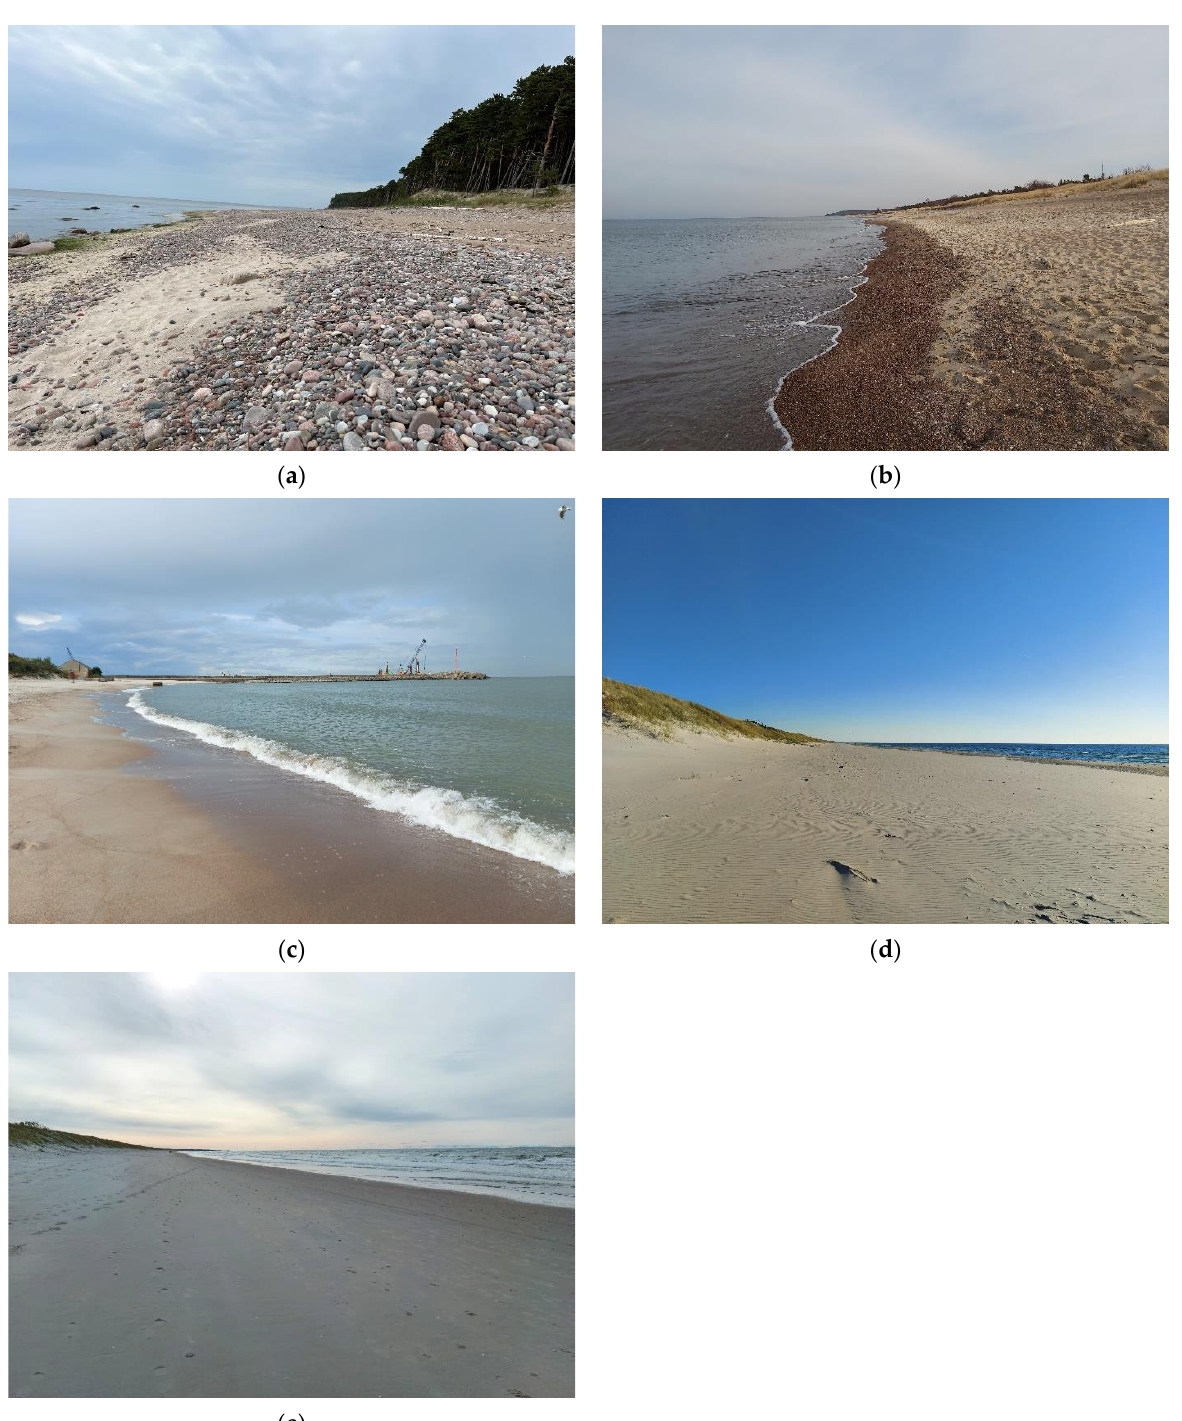
Figure 3 . Klaip ėda district municipality ’ s coast ( a ) Karklė; Klaipėda city municipality’ s official Figure 3. Klaip˙eda district municipality’s coast ( a ) Karkl˙e; Klaip˙eda city municipality’s official beaches: ( b ) Giruliai, ( c ) Melnragė I, ( d ) Smiltynė I, ( e ) Smiltynė II. beaches: ( b ) Giruliai, ( c ) Melnrag˙e I, ( d ) Smiltyn˙e I, ( e ) Smiltyn˙e